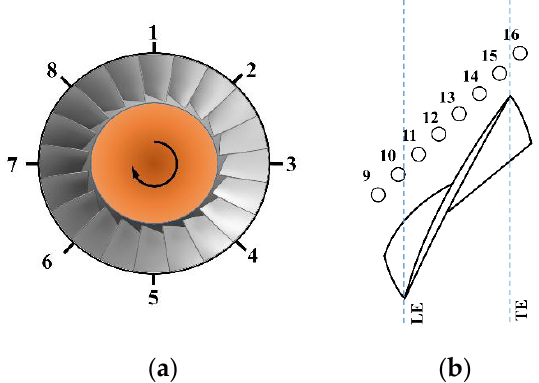
Figure 2. Layout of the pressure transducers: ( a ) circumferential distributed transducers, ( b ) chord distributed transducers.